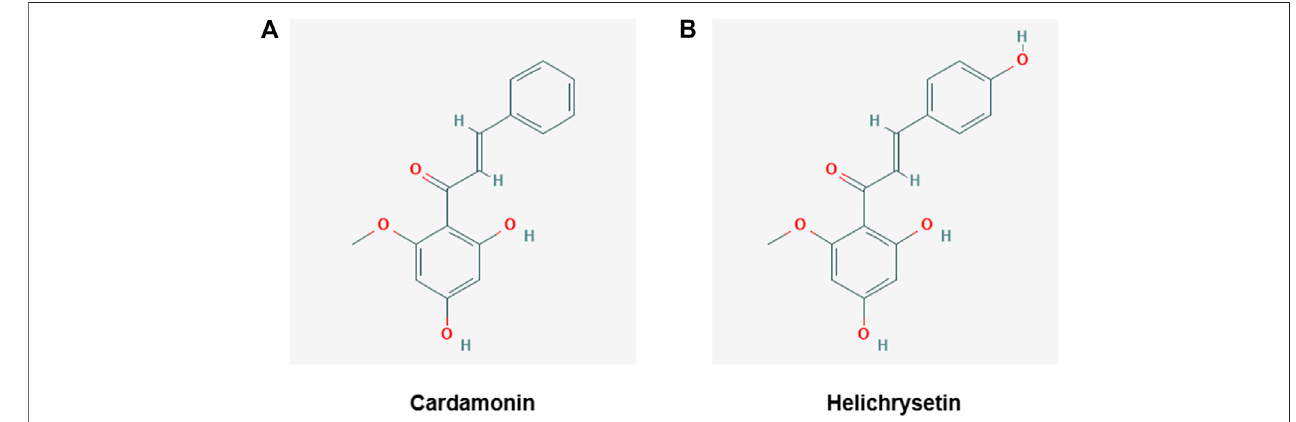
FIGURE 1 | Structures of cardamonin (A) and helichrysetin (B) .